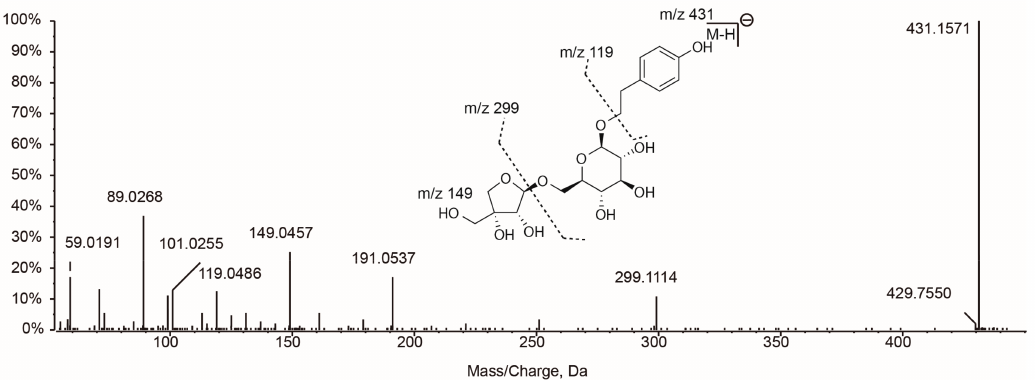
Figure 3. TOF-MS 2 spectrum and fragmentation scheme proposed for osmanthuside